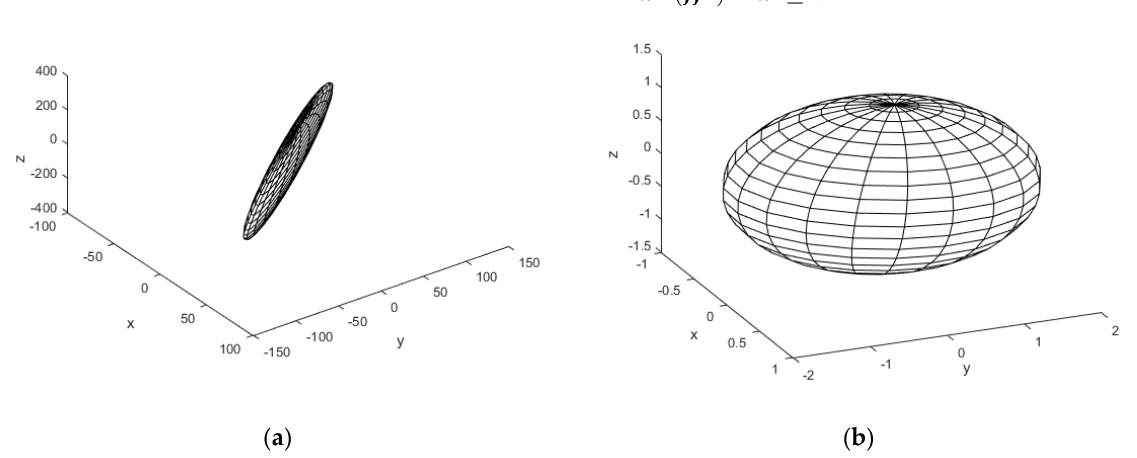
Figure 12. The EE translational velocity and rotational velocity ellipsoids. ( a ) Translational velocity ellipsoid ( b ) Rotational velocity